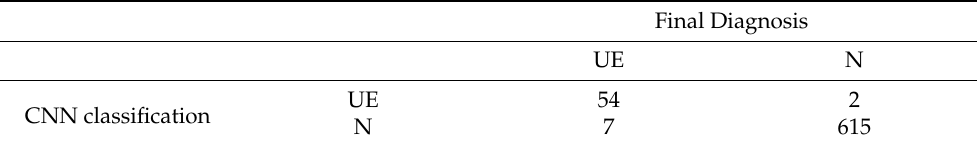
Table 2. Confusion matrix of the test set versus expert classification (considered the final